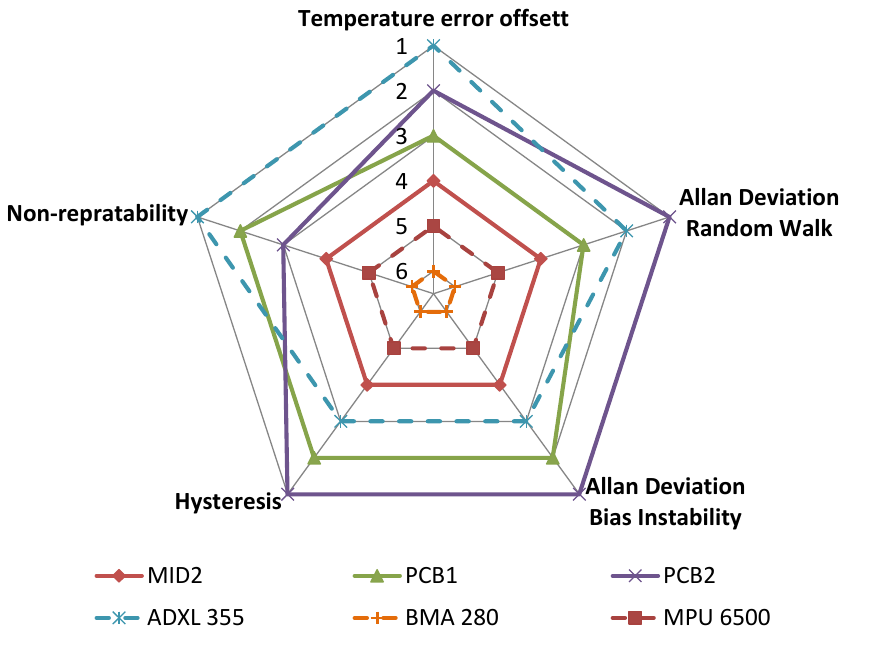
Figure 21. Comparison. Figure 21.